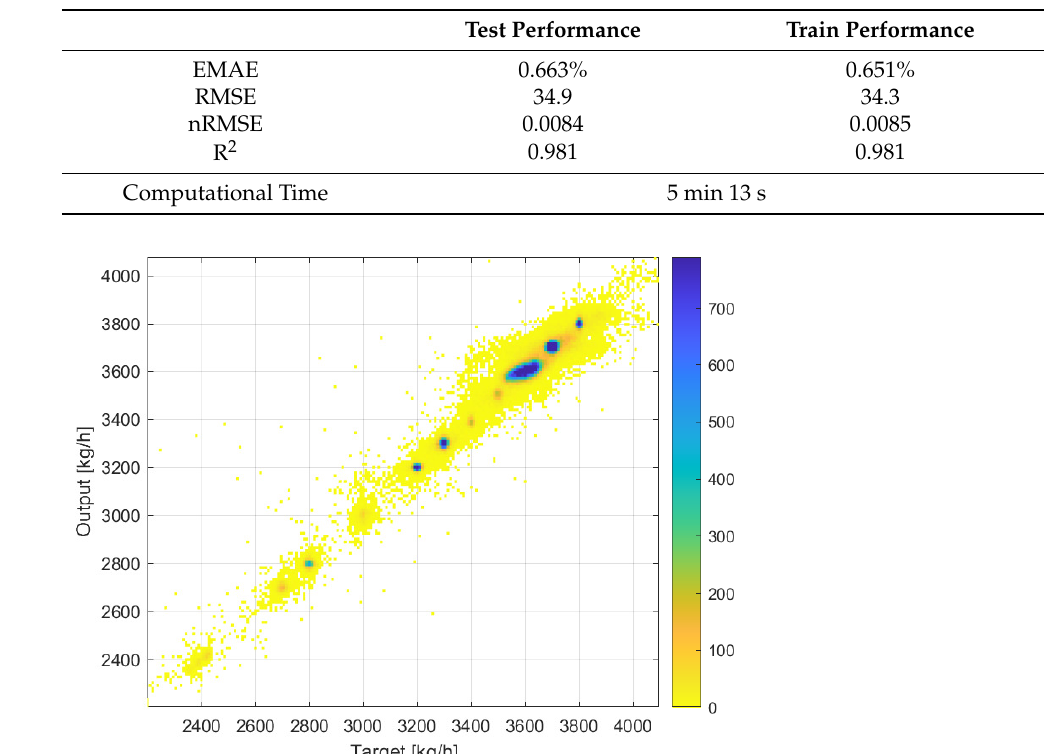
Table 5. Model performance for prediction of the steam flow rate: values of the errors evaluated on the training and testing data and related computational time required.